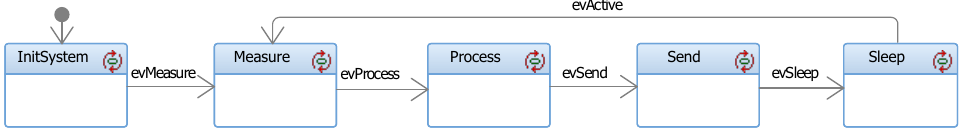
Figure 19. State machine of the software application modeled with IBM